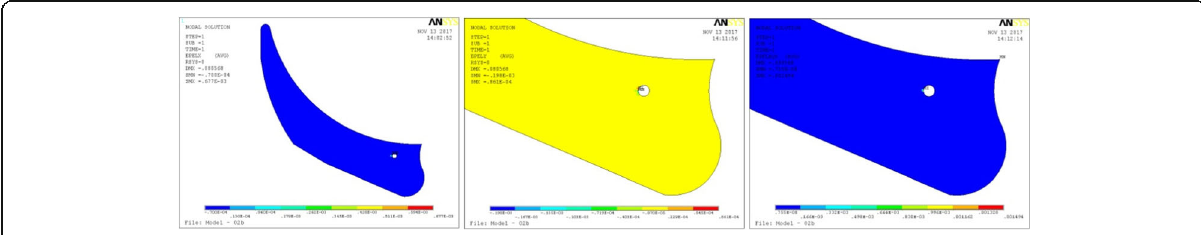
Fig. 4 Mandibular strain in X and Y directions and total strain